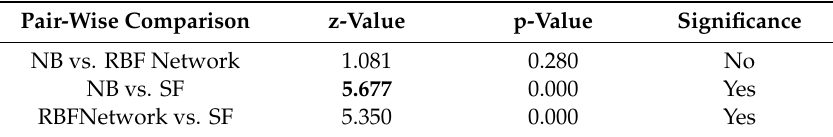
Table 4. Results of the Wilcoxon signed-rank test